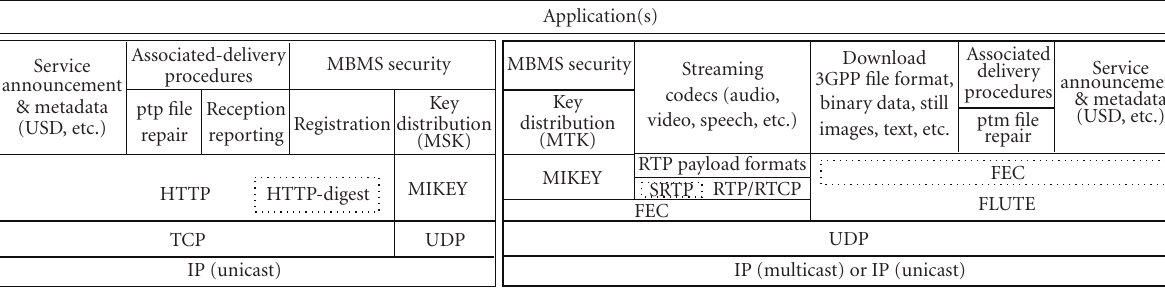
Figure 9: Protocol stacks used for MBMS User